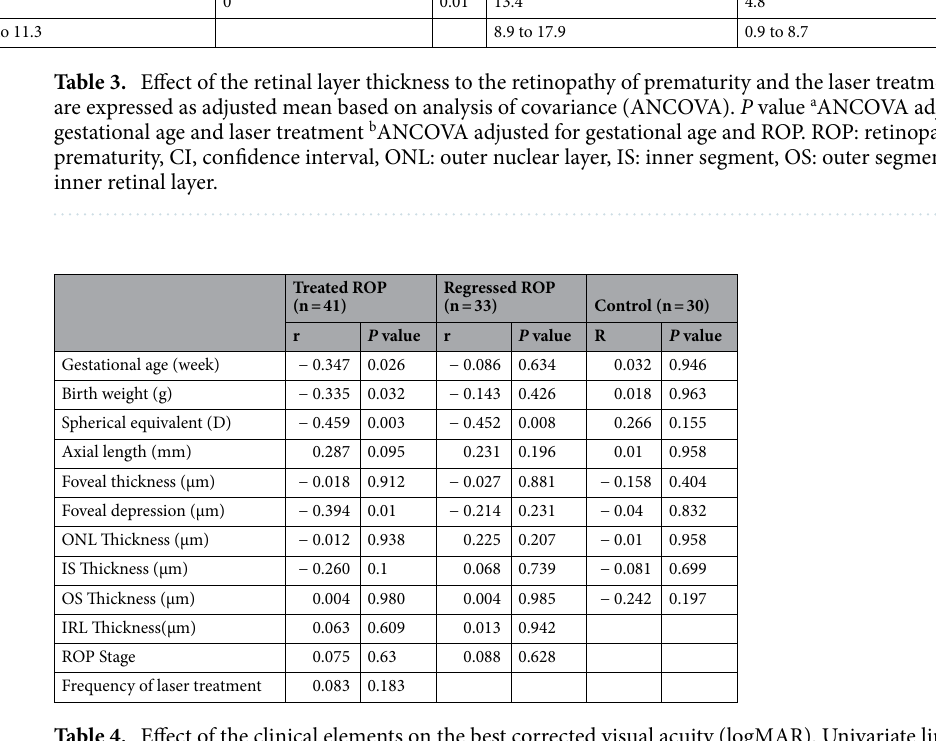
Table 4. Effect of the clinical elements on the best corrected visual acuity (logMAR). Univariate linear regression analysis was performed. logMAR: logarithm of the minimum angle of resolution, ROP: retinopathy of prematurity, ONL: outer nuclear layer, IS: inner segment, OS: outer segment, IRL: inner retinal